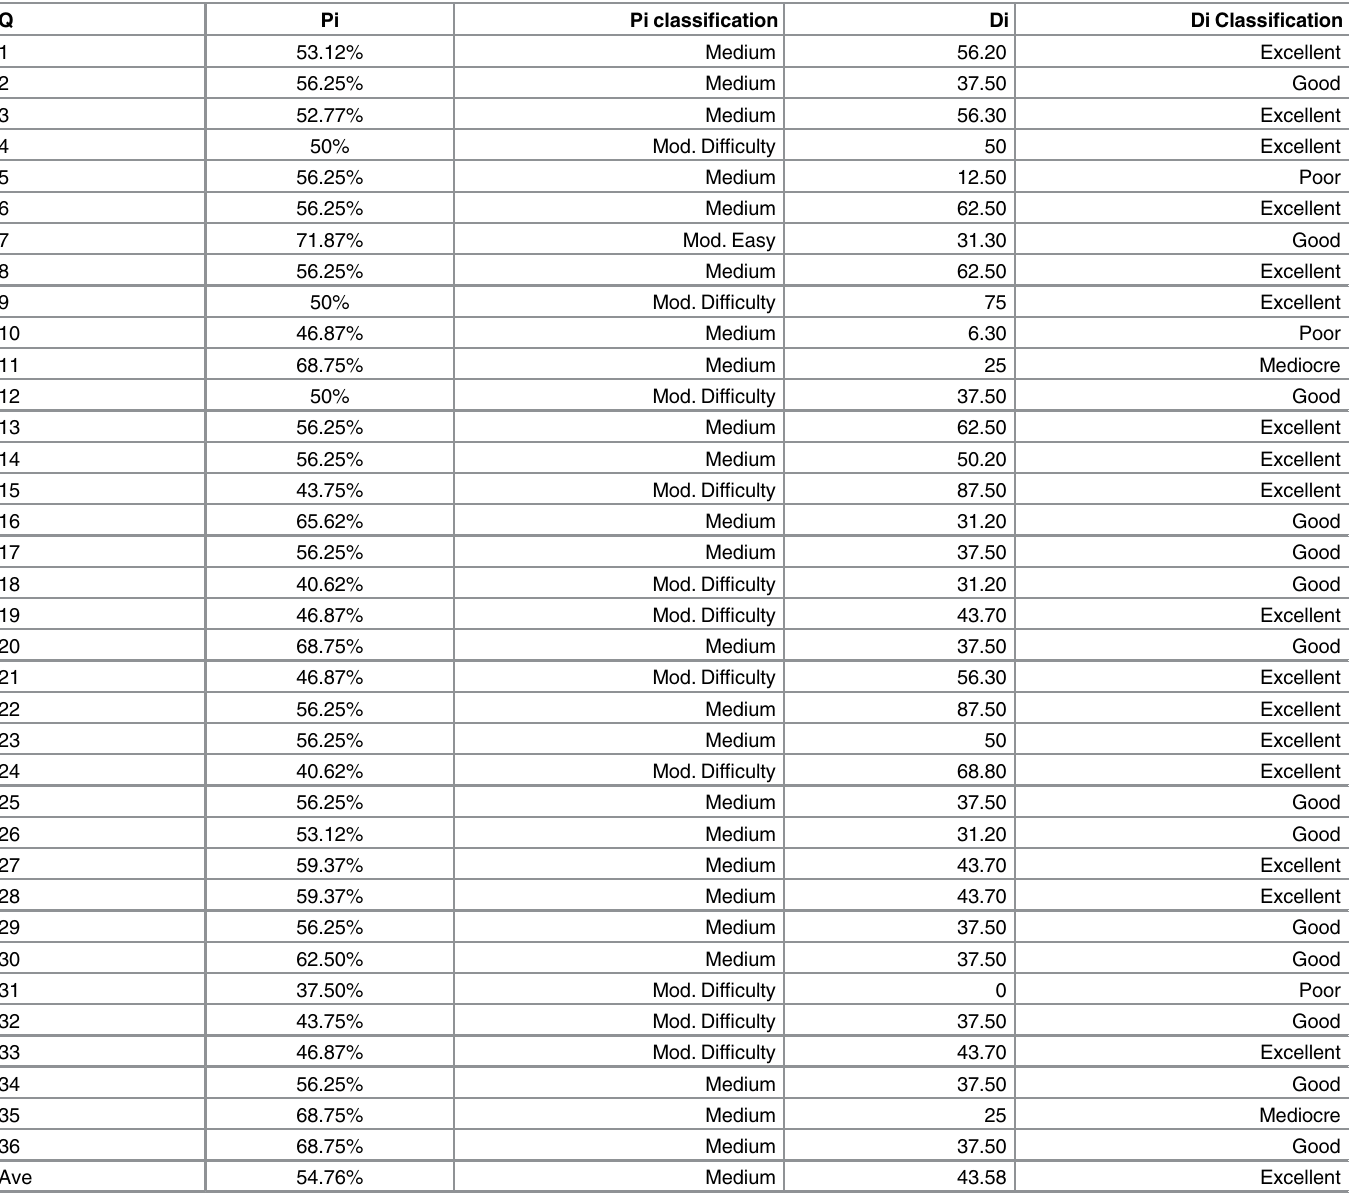
Table 4. ALS Difficulty and Discrimination